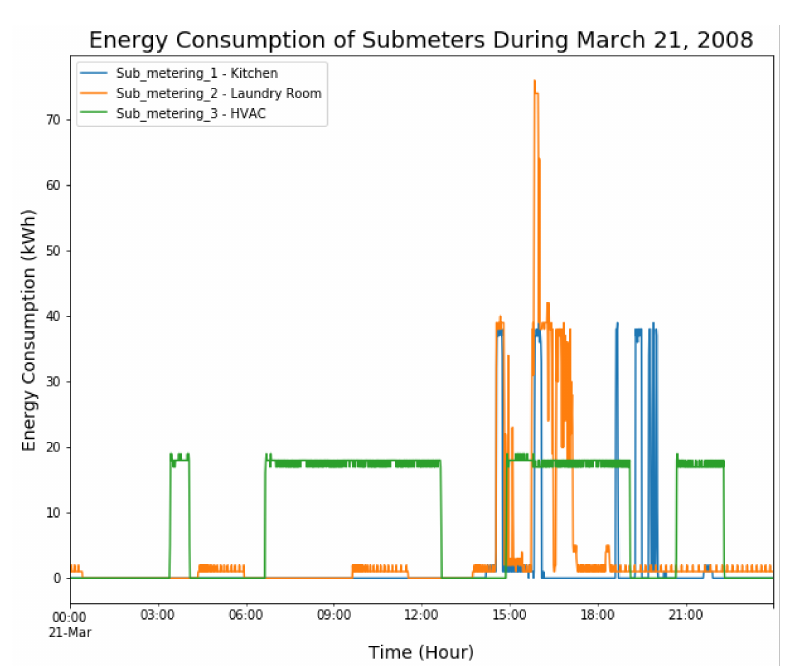
Figure 1. Sample of energy usage data acquired from the